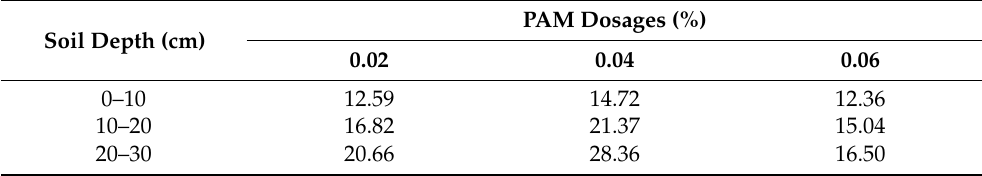
Figure 2. Effect of PAM dosages on soil water content distribution. Table 1. Soil water holding efficiency (%) under different PAM dosages.